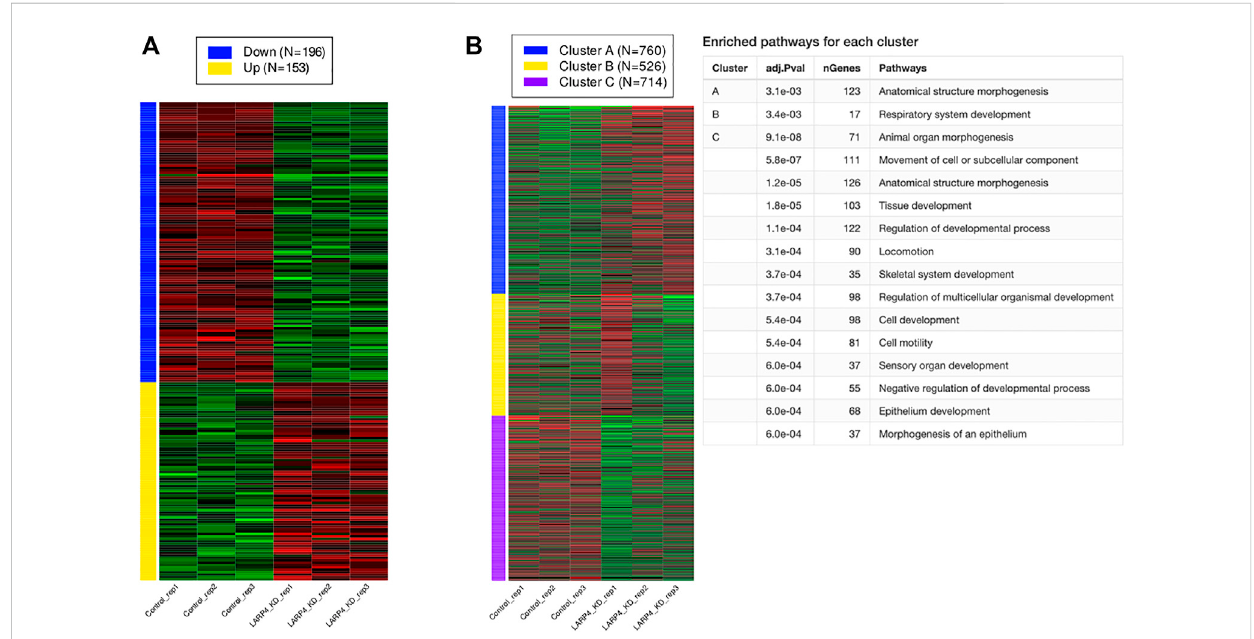
FIGURE 7 KD of LARP4 related to cell migration and morphogenesis. Differentially expressed genes (DEGs), K-means clustering, and enrichment analysis. (A) Numbers and expression patterns of DEGs in HEK293T cells transfected with control or LARP4 siRNA among 15,070 genes (GSE139548). (B) K-means clustering and enrichment